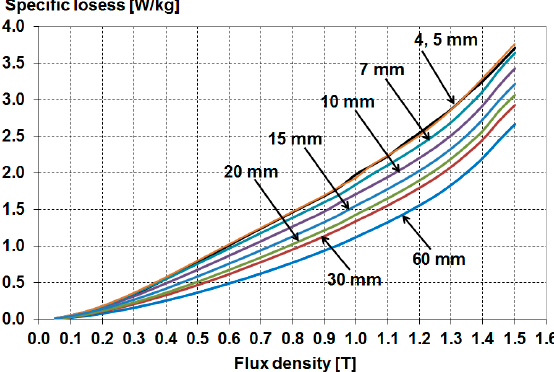
Figure 20. Measured loss characteristics of the M 270-35A sheet for various widths of laser cut sheet samples.